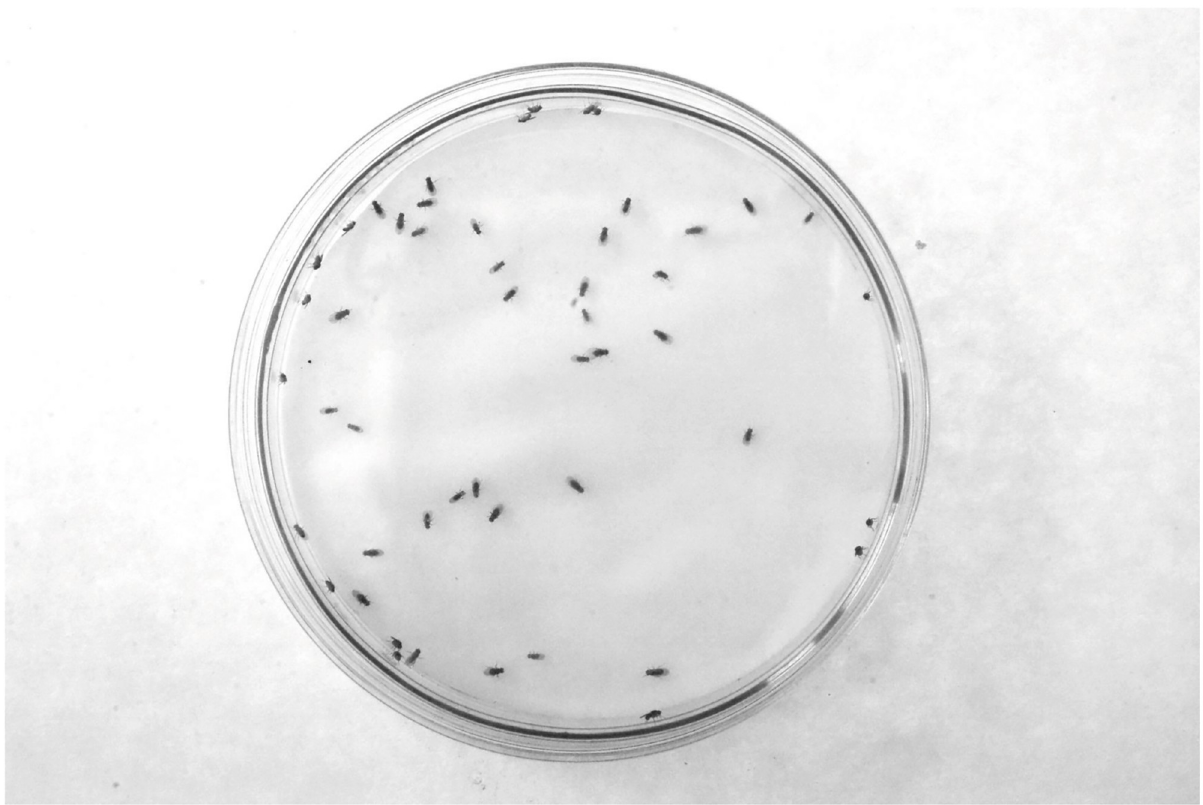
Fig 5. Adult D . melanogaster grouped in a Petri dish. The adults (N = 50 males) shown belong a strain formed with individuals collected in the grape orchard (Fig 1).